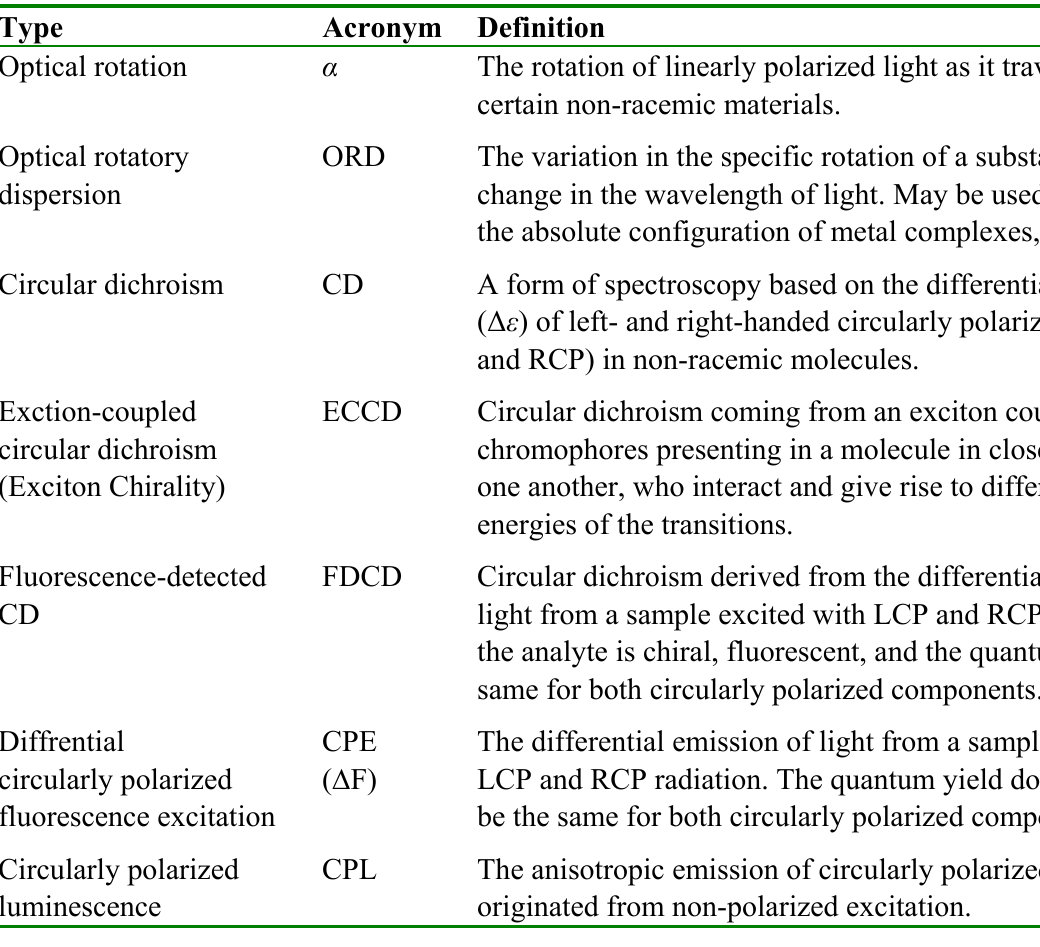
Table 1. Terms and definitions in chiroptical